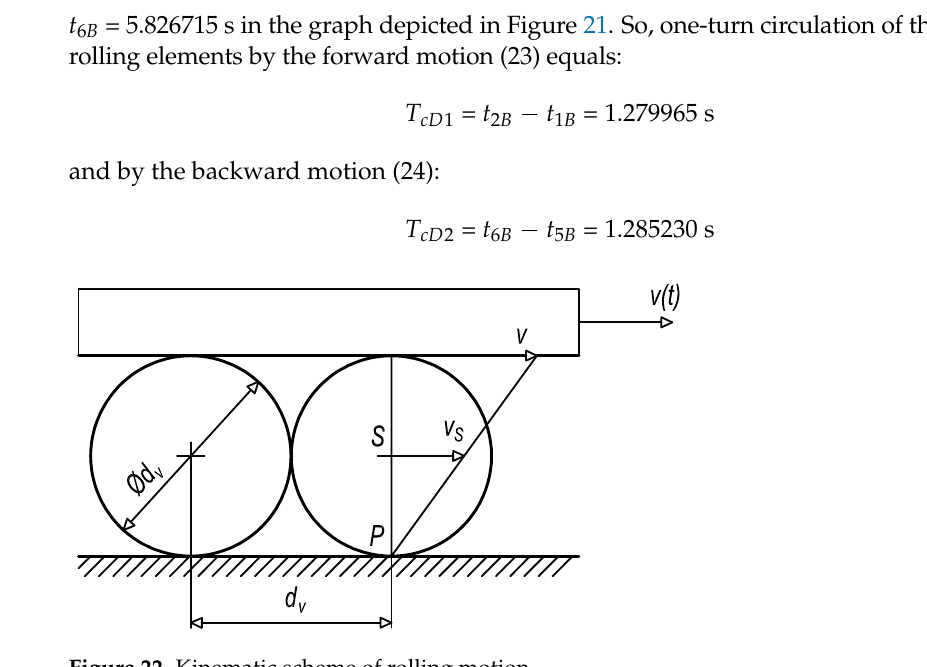
Figure 22. Kinematic scheme of rolling motion.